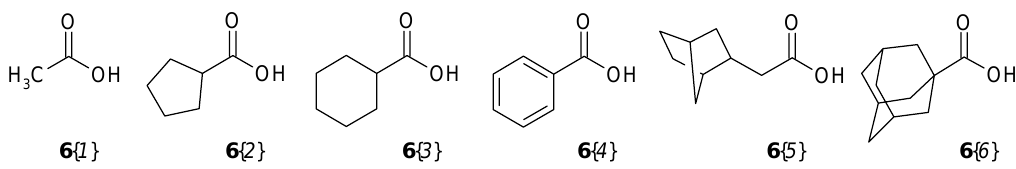
Figure 5. Diversity of carboxylic acids 6 { 1–6 }.